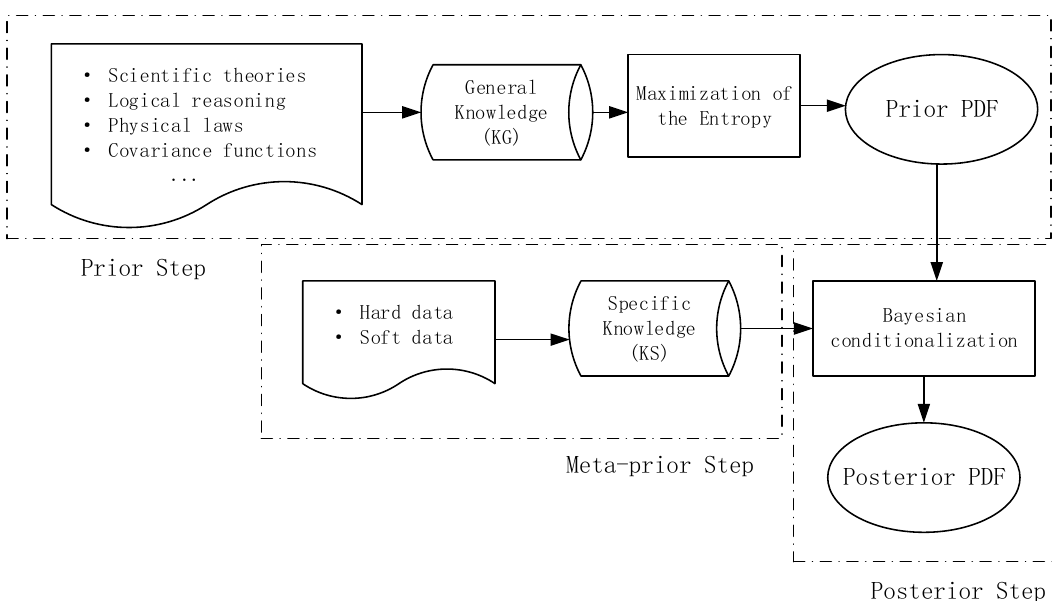
Figure 3. Flowchart of the Bayesian Maximum Entropy (BME) framework. PDF stands for probability density function.